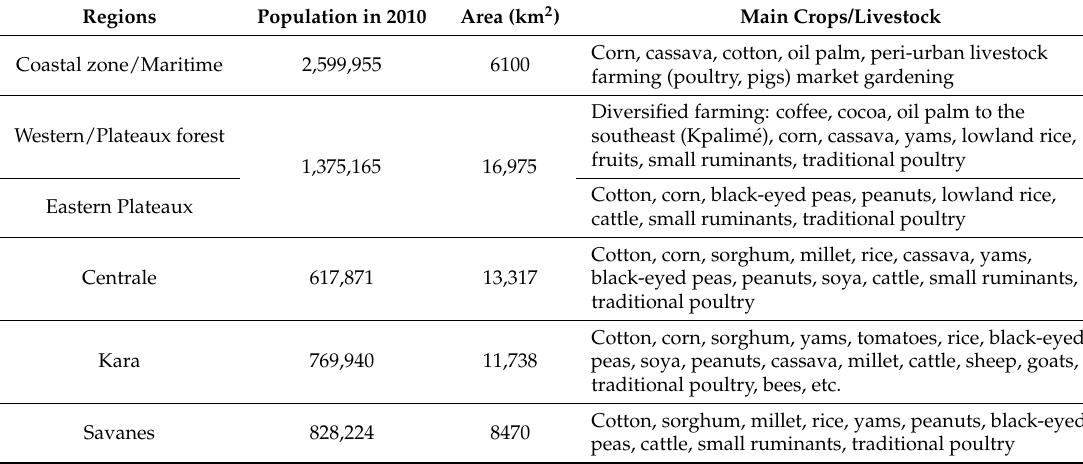
Table A2. Distribution of major crops/livestock by